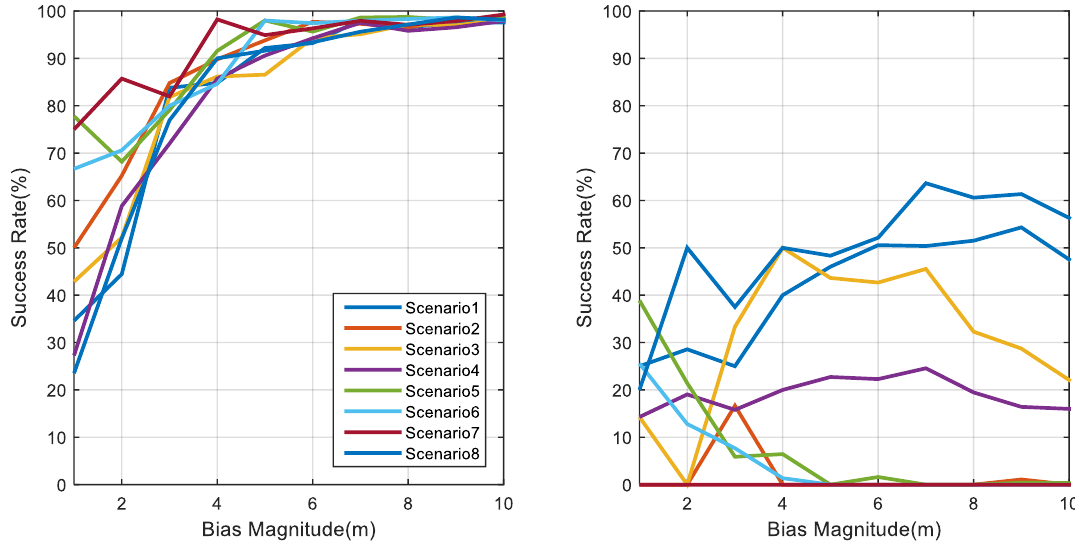
Figure 13. Compare of success rate with different NLOS bias and anchor geometry scenarios for the MC algorithm ( Left ) and the ML method ( Right ).